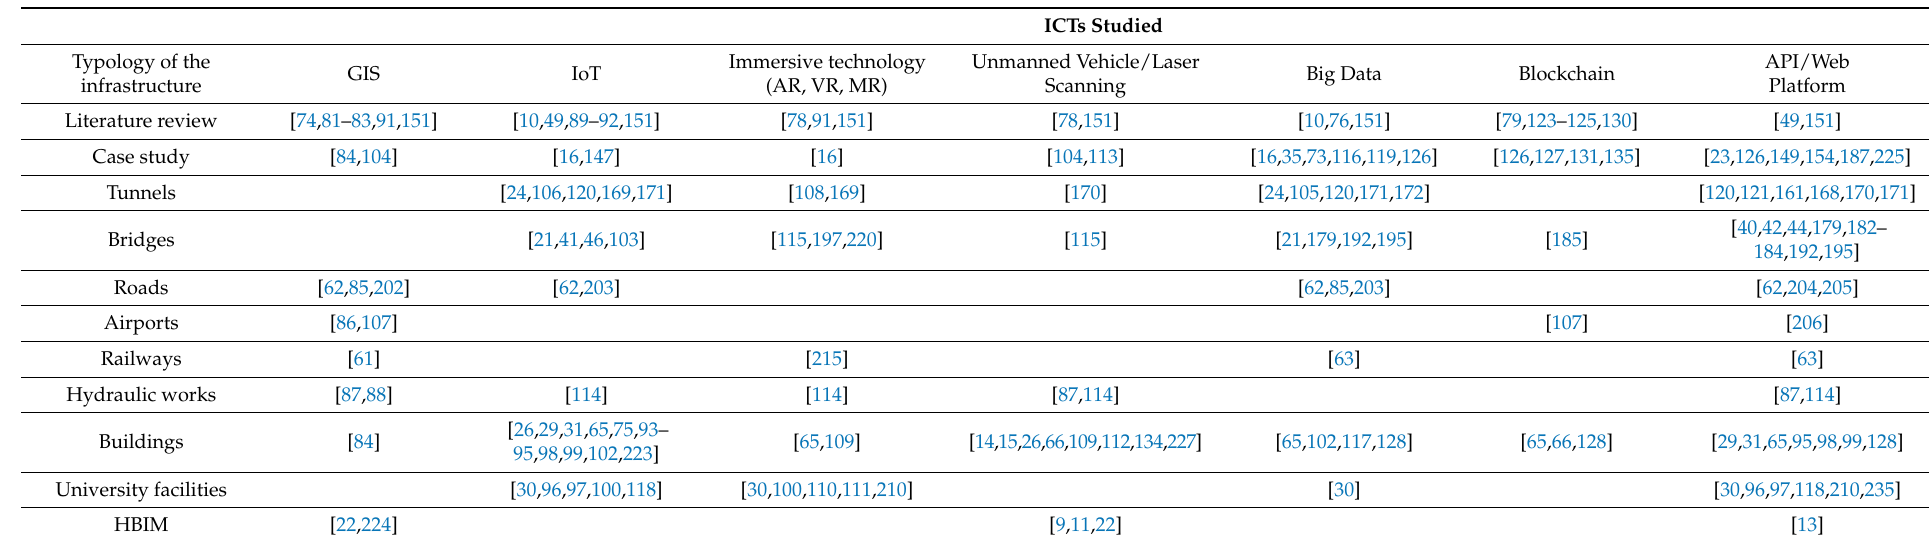
Table 2. Categorisation of